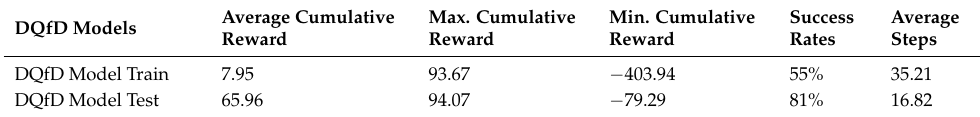
Figure 21. DQfD Model Test Results. Table 6. DQfD Model Train and Test